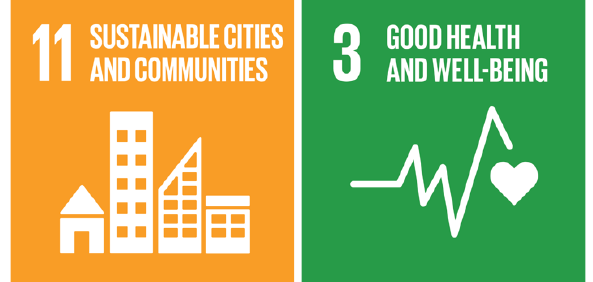
Figure 1. SDG 11 and 3, which will be in focus for the specific case in this